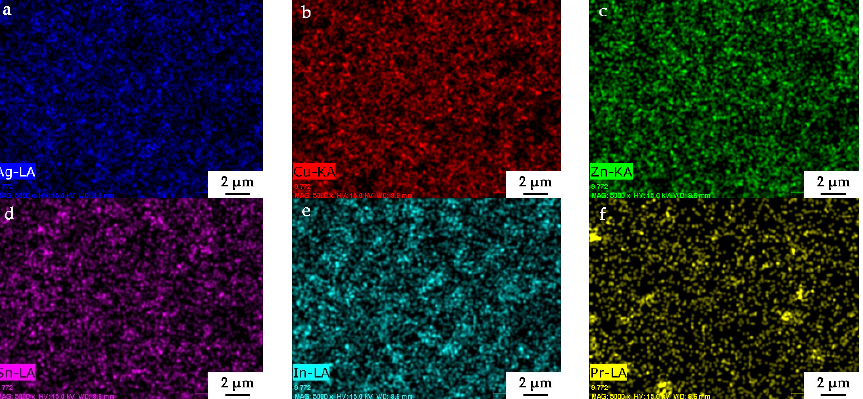
Figure 10. Fracture morphologies of the brazing joints using different low-silver filler metals: ( a ) 12AgCuZnSn-1In-0.1Pr, ( b ) 12AgCuZnSn-2In-0.1Pr, ( c ) 12AgCuZnSn-2In-0.15Pr, ( d ) 12AgCuZnSn-2In-0.3Pr, ( e ) 12AgCuZnSn-2In-0.5Pr, ( f ) 12AgCuZnSn-5In-0.5Pr.